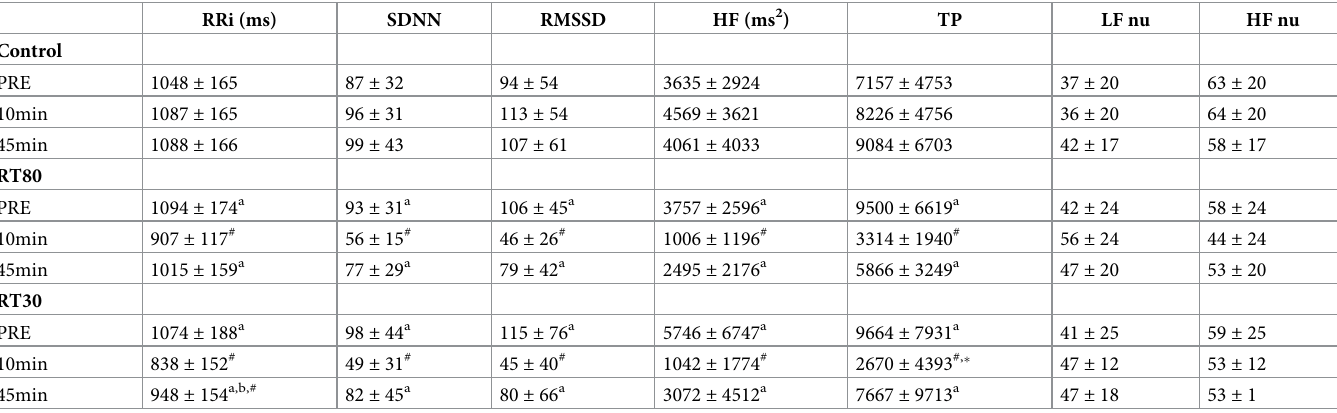
Table 2. Heart rate variability before (PRE) and after 10 (10min) and 45 (45min) minutes after a low-load (30% of 1RM; RT30) or a high-load (80% of 1RM; RT80) RT protocol performed to momentary failure or a control session without exercise